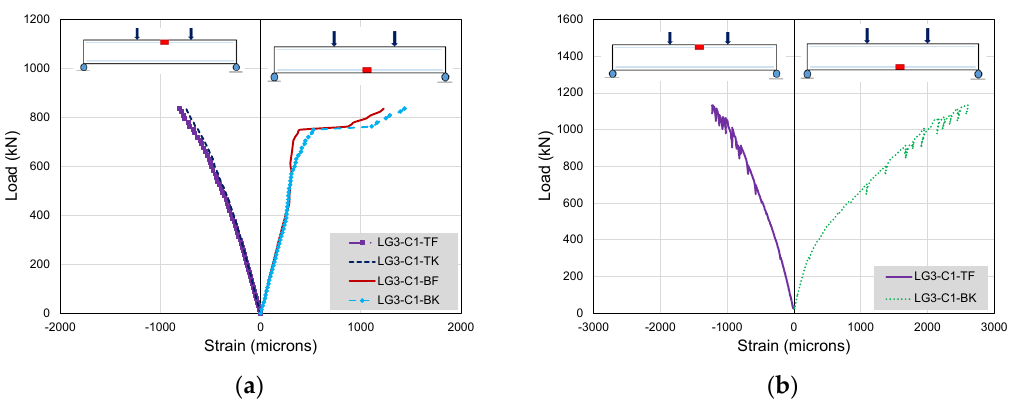
Figure 20. Strain versus load responses ( a ) load setup SP-3-L01 and ( b ) load setup SP-3-L02.